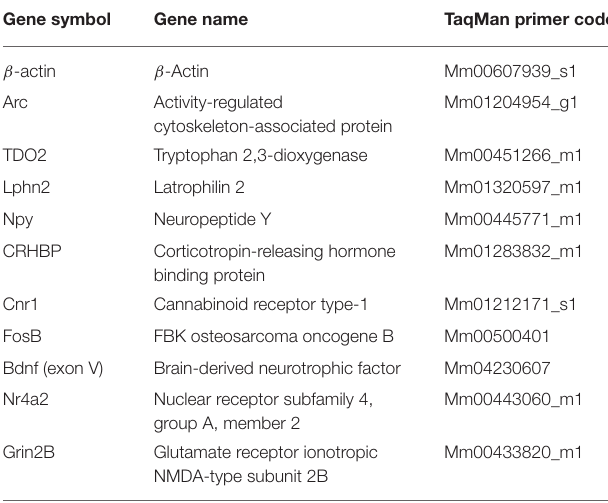
TABLE 1 | List of TaqMan primers used for